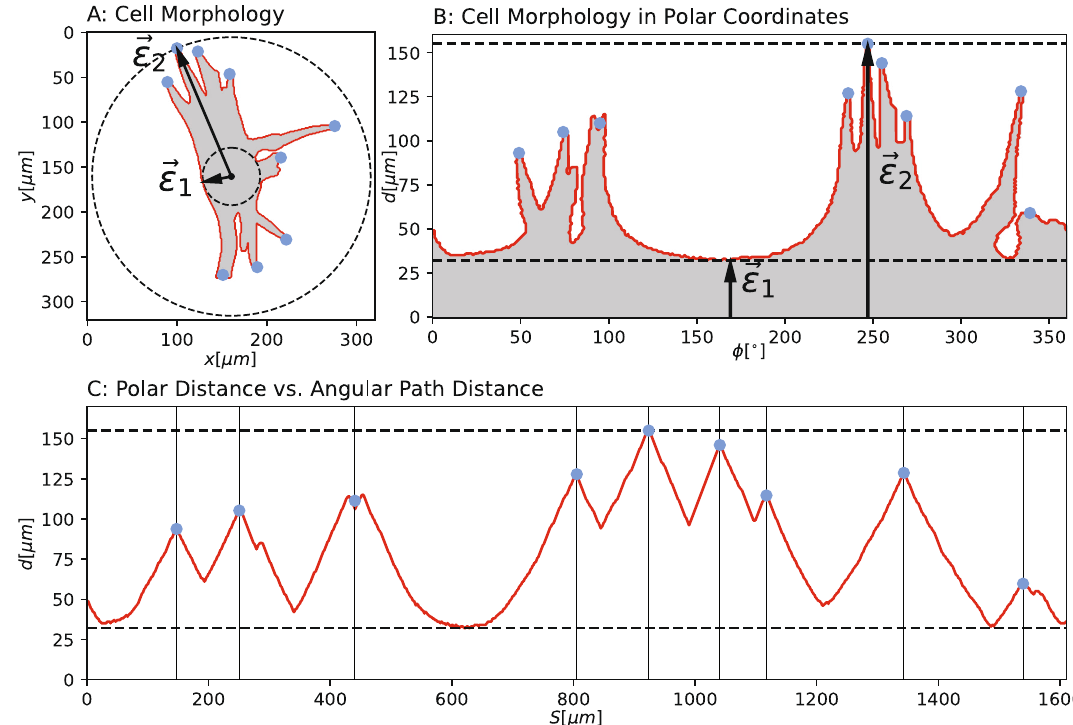
Figure 10. Cell protrusion evaluation: ( A ) Cell mask with protrusion tips (blue) and eccentricity vectors , ε 2 n ε 1 n ( ), which are computed through the polar representation ( B ) and the index based (unraveled) polar | | |� |� representation ( C